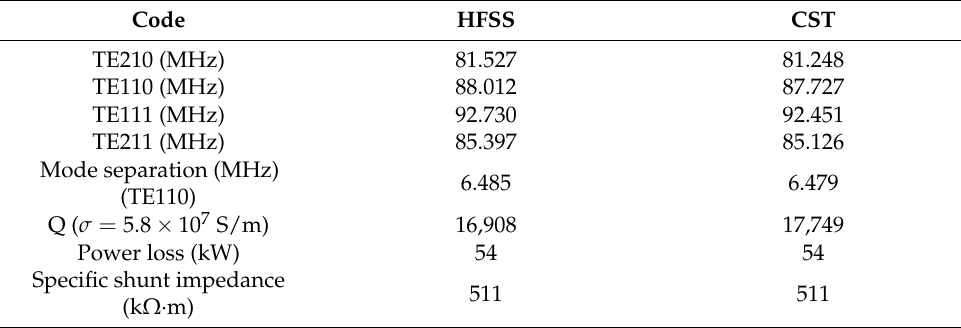
Table 6. Simulations of the full-length model with vane modulation.